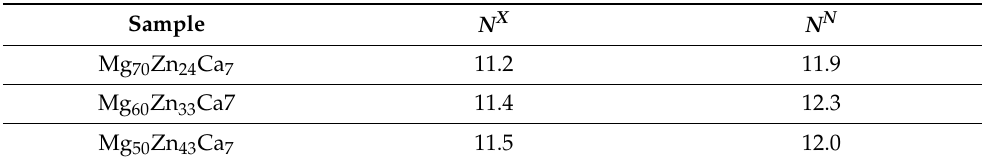
Table 2. Total coordination numbers, N X and N N , calculated in the range of 2.3 Å to 4.0 Å from D X ( r ) and D N ( r ) functions, respectively.